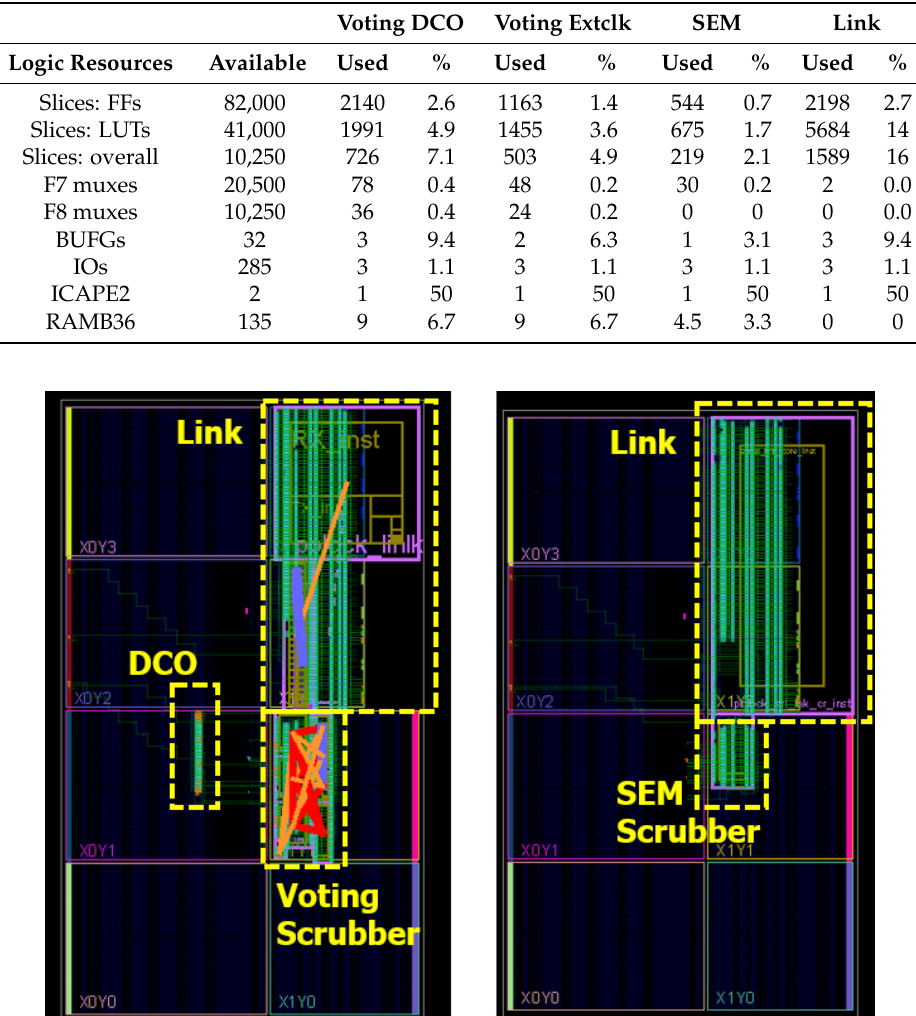
Figure 5. Layout of the link node and scrubber in a Xilinx 7K70T device: ( Left ) version with voting scrubber clocked by DCO; and ( Right ) version with Xilinx SEM clocked by an external